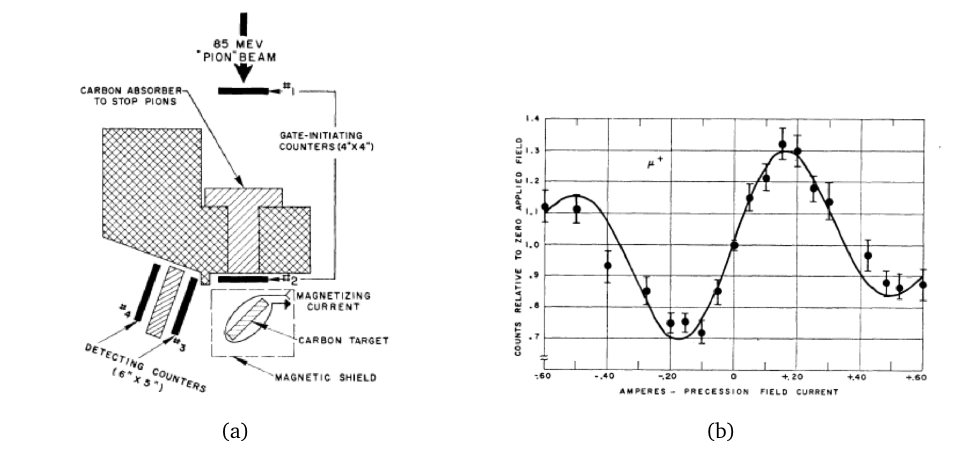
Figure 1: (a) The experimental arrangement at Nevis. 85 MeV π + µ + beam is inci- dent. Four scintillation counters 1 − 4 defined an incident muon and a delayed muon decay. The signal was 1 · 2, followed by a delayed 3 · 4 coincidence within the time window of 0.75 - 2 µ s. (b)The data from Garwin et al., [ 20 ] showing the number of counts as a function of magnetic field during a narrow time window. (Reprinted with permission from Ref. [ 20 ] Copyright 1957 by the American Physical